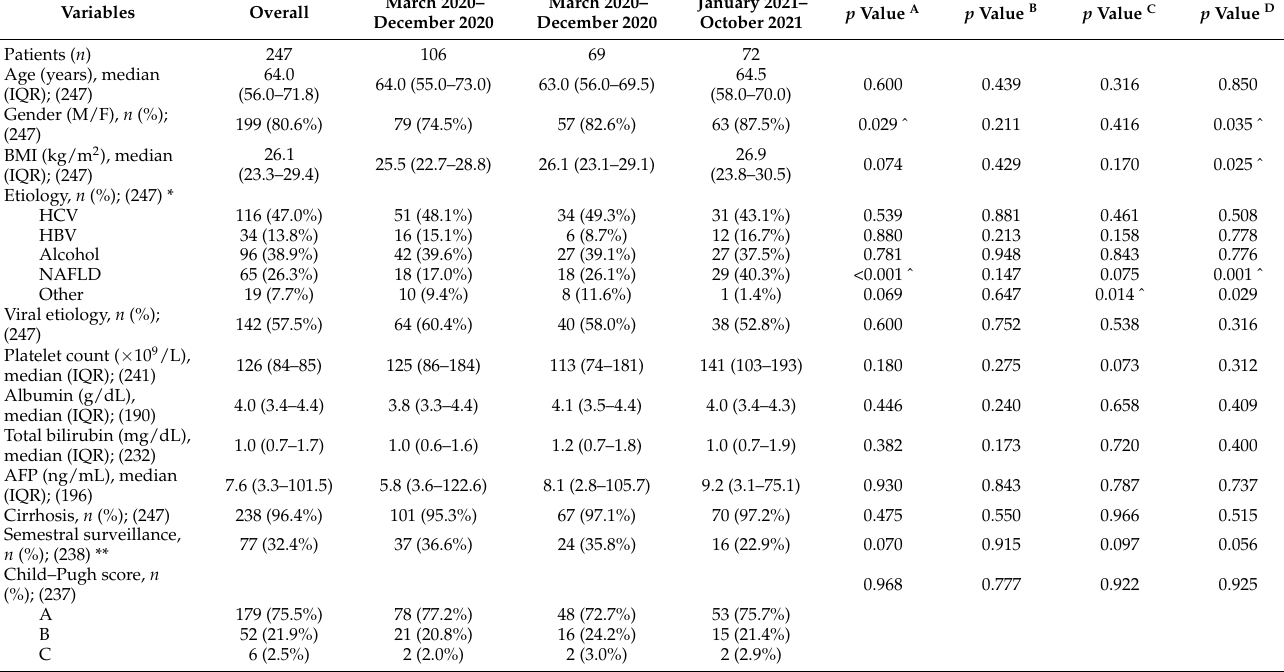
Table 1. Characteristics of the patients included in the study according to the different periods of